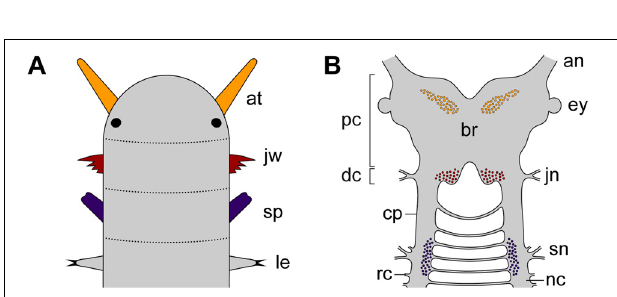
FIGURE 2 | Diagrams illustrating segmental identity of modified cephalic appendages and position of corresponding neuronal somata in the central nervous system of Onychophora. Modified from Mayer et al. (2010). (A) Assignment of four anterior-most pairs of limbs to corresponding segments (demarcated by dotted lines). Black-filled circles indicate the position of eyes. (B) Position of neuronal cell bodies innervating the three pairs of cephalic appendages, including the antennae, the jaws, and the slime papillae. Note that the somata of neurons supplying the slime papillae lie outside the brain. Abbreviations: an, antennal nerve; at, antenna; br, brain; cp, connecting piece; dc; deutocerebral region; ey, eye; jn, jaw nerve; jw, jaw; le, first walking leg; nc, nerve cord; pc, protocerebral region; rc, ring commissure; sn, slime papilla nerve; sp; slime papilla.